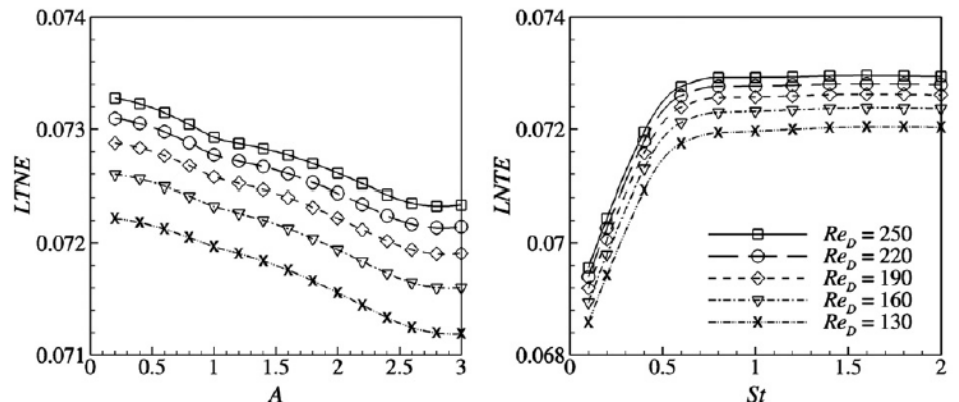
Figure 25. Influence of ( Left ) amplitude, and ( Right ) frequency (St), of an oscillating flow on the LTNE parameter, for various Reynolds numbers, reported by Al-Sumaily et al. [49].